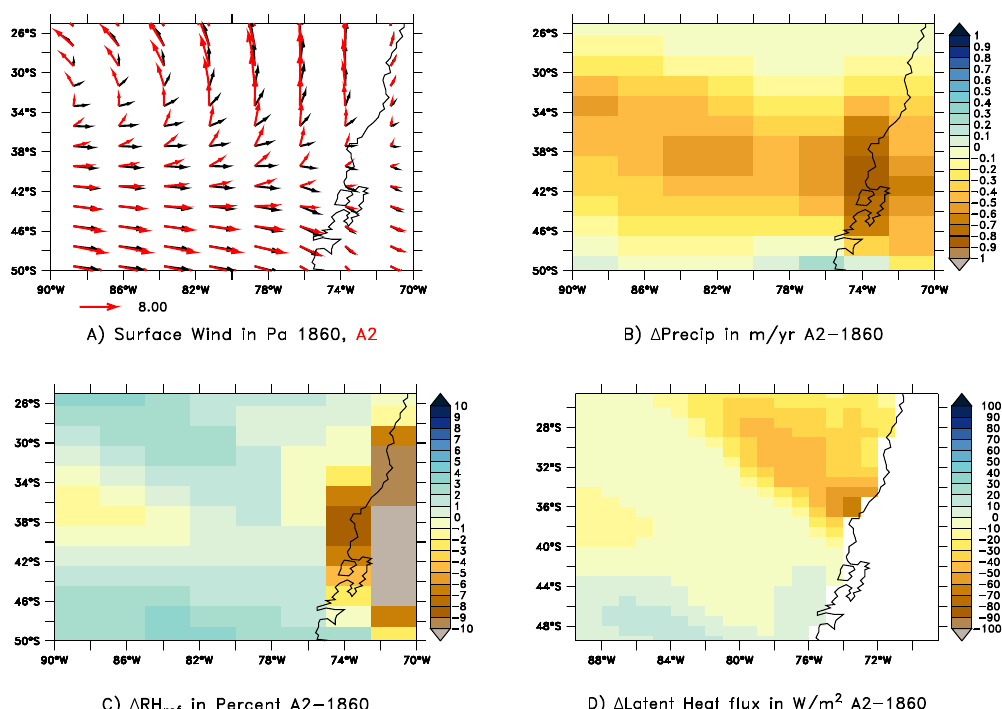
Fig. 7. Atmospheric changes under global warming in the Southeast Pacific. (A) Annual-mean surface winds for years 521–540 1860 control (black) and years 2281–2300 of A2 scenario (red). (B) Change in precipitation in myr − 1 . (C) Change in relative humidity in %. (D) Change in latent heat flux (negative is loss from ocean) in Wm − 2 .